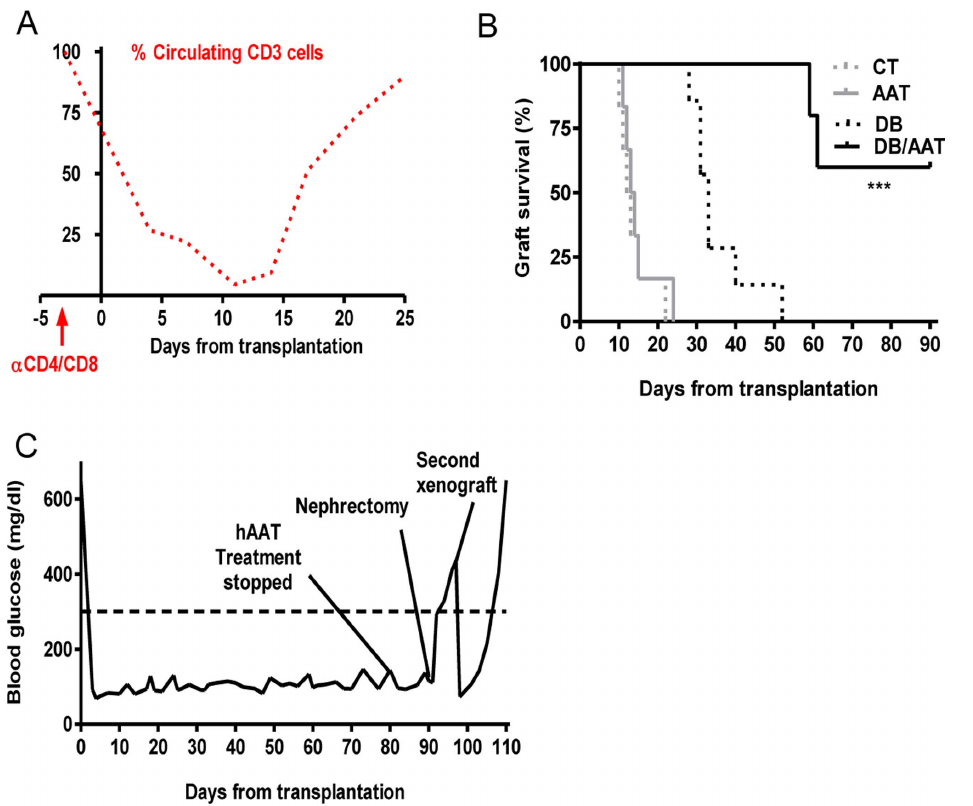
Figure 3. AAT treatment combined with debulking therapy; graft survival. (A–C) Rat islets were grafted into mice that were treated with anti-CD4/CD8 depleting antibodies, in the absence of AAT therapy ( n =7) or with added AAT therapy ( n =5). ( A ) CD45 + CD3 + cells from peripheral blood, as monitored by FACS analysis. Results presented as the percent out of initial amount prior to injection. Representative follow-up out of 10 mice. ( B ) Islet xenograft survival curve. ***p , 0.001 between DB and BD/AAT. ( C ) Glucose follow-up. Representative mouse. Milestones indicated: hAAT treatment stopped, therapy withdrawn followed by glucose follow-up; nephrectomy , graft explantation followed by glucose follow-up; second xenograft , rat islets grafted into the right renal subcapsular space followed by glucose follow-up. groups on day-90. Rat insulin transcripts were greater in day-90